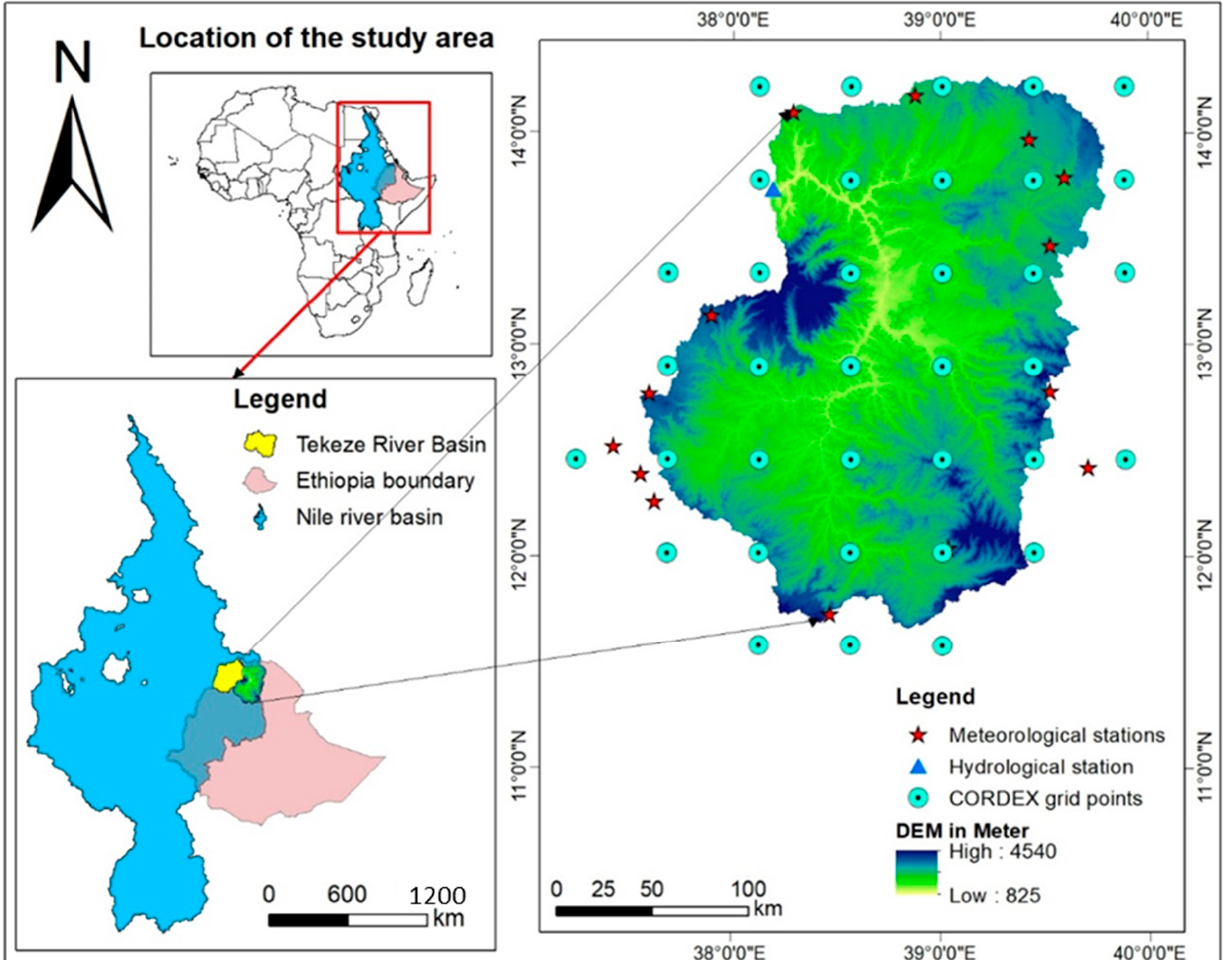
Figure 1. Location of the study area along with digital elevation model (DEM), location of hydrological and meteorological stations, and CORDEX grid points.